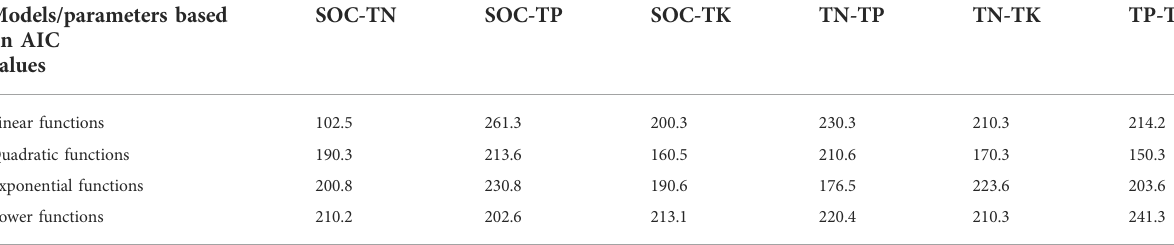
TABLE 4 Average AIC values of the different fi tting